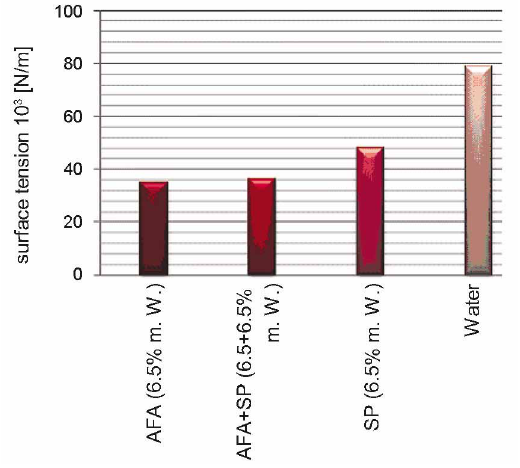
Fig. 6. The influence of a type of admixture on the surface tension of water; SP based on polycarboxylate (PCP); and AFA based on polyalcohol (Łaźniewska-Piekarczyk 2008c)